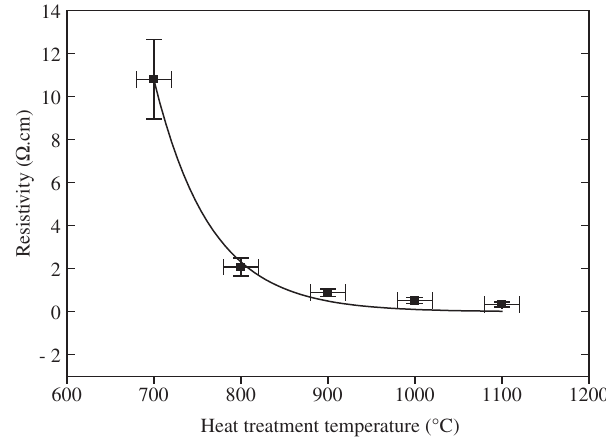
Figure 3. FT-IR spectra of RVC samples heat treated at 700 °C and 1000 °C. The interval between 1700 and 1100 cm -1 suggest the presence of functionali- ties. The relevant contributions are marked in